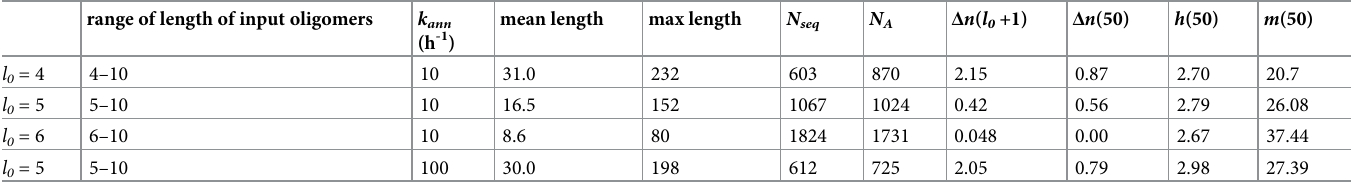
Table 6. Comparison of runs with different values of the minimum helix length l 0